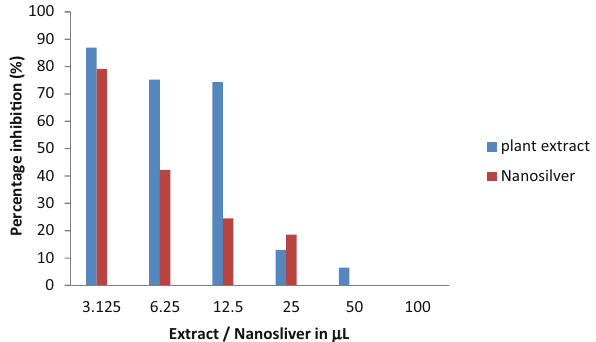
Figure 7: Cytotoxicity of aqueous R. o ffi cinalis leaf extract and its AgNPs on breast cancer cell lines ( MDA MB 231 ) following 24 h